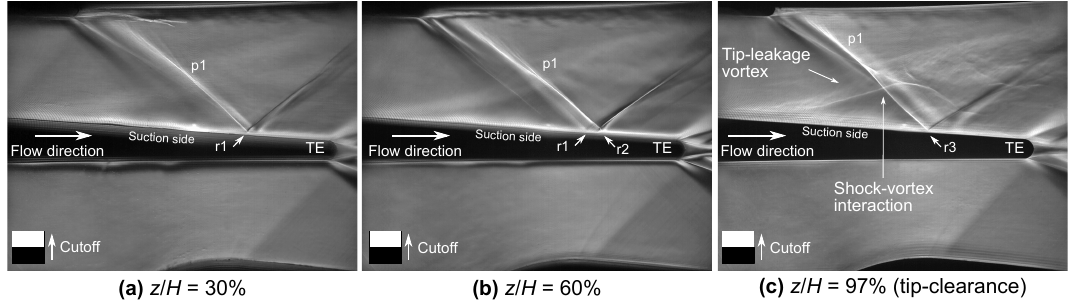
Figure 7. Focusing schlieren images of the flow field in three different planes of focus for the idealized tip-clearance model. The tip-leakage vortex and its development along the chord length is shown for a tip-clearance of τ / H = 2.8% and M 2, is = 1.6.